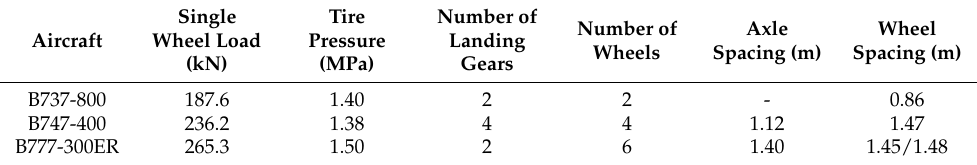
Table 5. Loading parameters of the landing gears for selected typical aircraft.